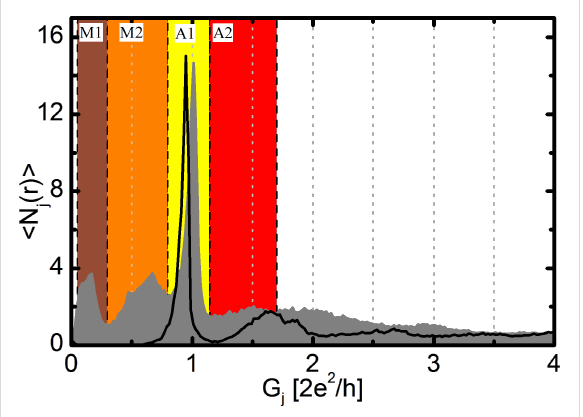
Figure 1: Conductance histogram of Au junctions before (black) and after (grey) the dosing of CO molecules. The latter shows two new molecular peaks at 0.17 G 0 and 0.67 G 0 . The color background shows the important conductance regions discussed in the text: M1 (0.05–0.3 G 0 , brown), M2 (0.3–0.8 G 0 , orange), A1 (0.8–1.1 G 0 , yellow) and A2 (1.1–1.7 G 0 , red). All histograms are normalized to the number of